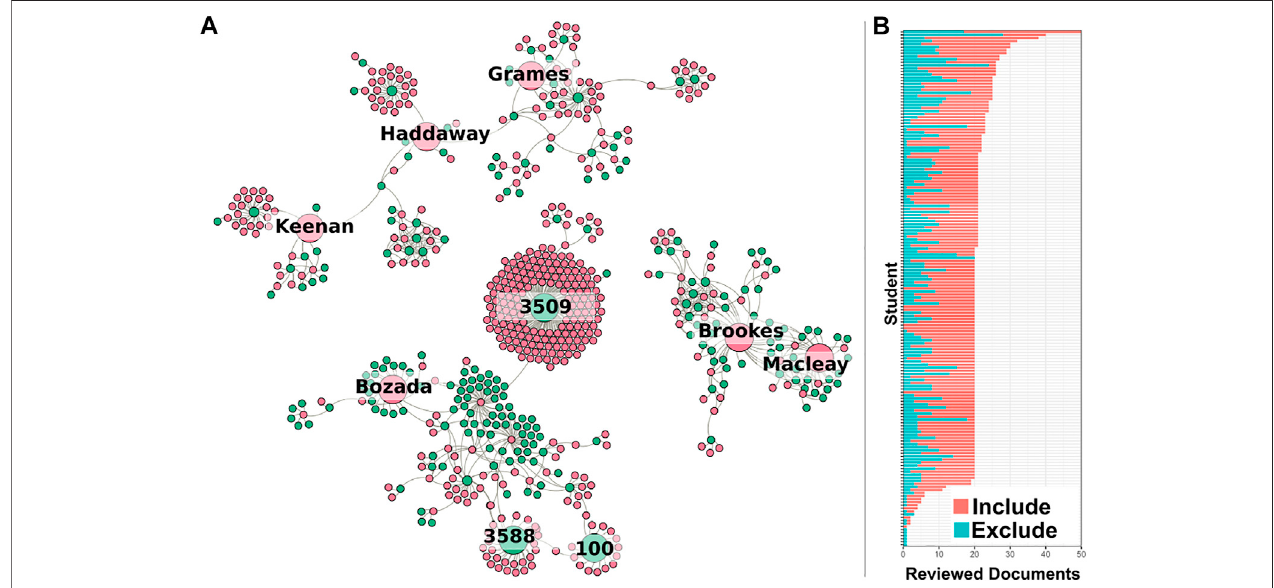
FIGURE 6 | (A) Three of the larger communities on sysrev.com. Pink nodes represent users, green nodes represent projects. Edges link projects with their users. Severalnotableprojects and users have been enlarged for discussion. (B) Bar chart representingcompleted document reviews for each student in sysrev.com/p/3509, an educational review focused on evidence based toxicology by Dr. Lena Smirnova. Each bar represents a student, students were asked to complete a review of 20 documents, blue bars indicate excluded articles, red bars indicate included articles in an article screening